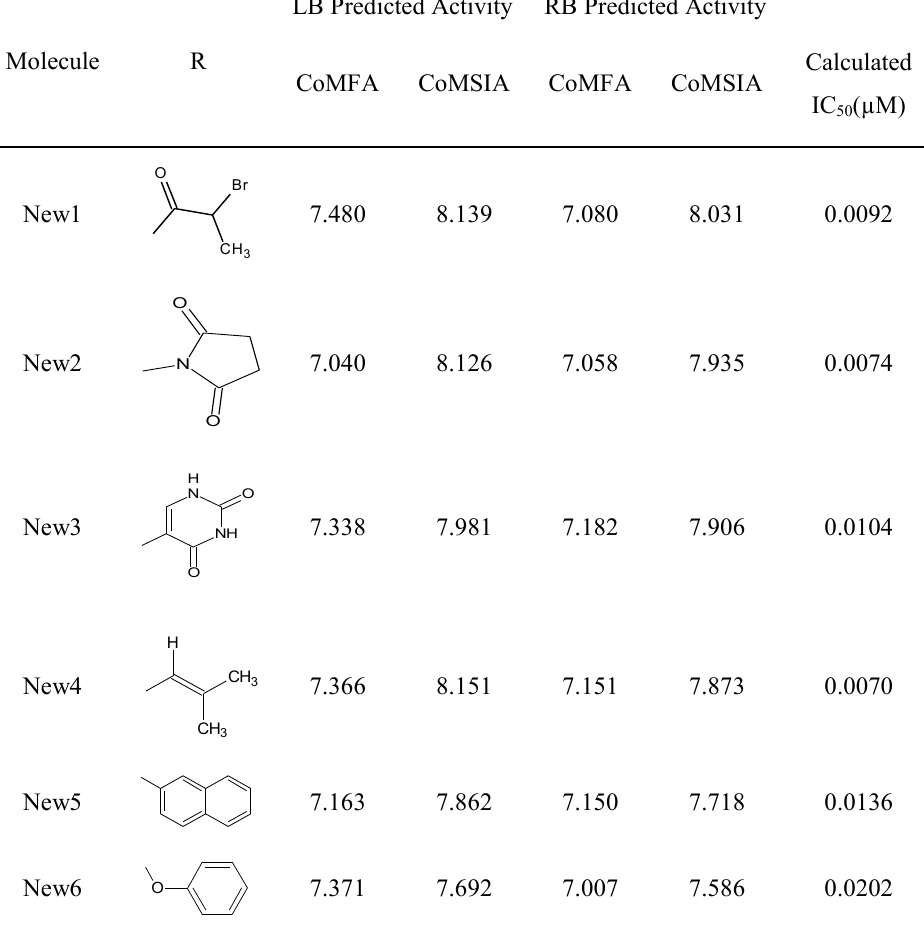
Table 3. The LB and RB Predicted activity values of newly designed molecules.